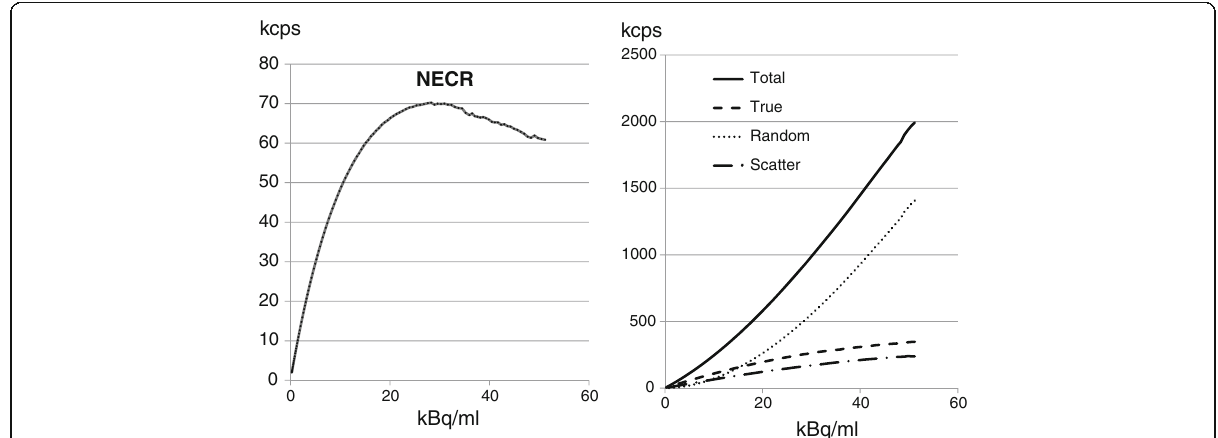
Fig. 3 The activity-rate curves. The curves of total, true, random, and scatter events are shown on the right and that of NECR is shown on the left. The peak NECR was 70 kcps when the phantom contained 29.6 kBq mL −